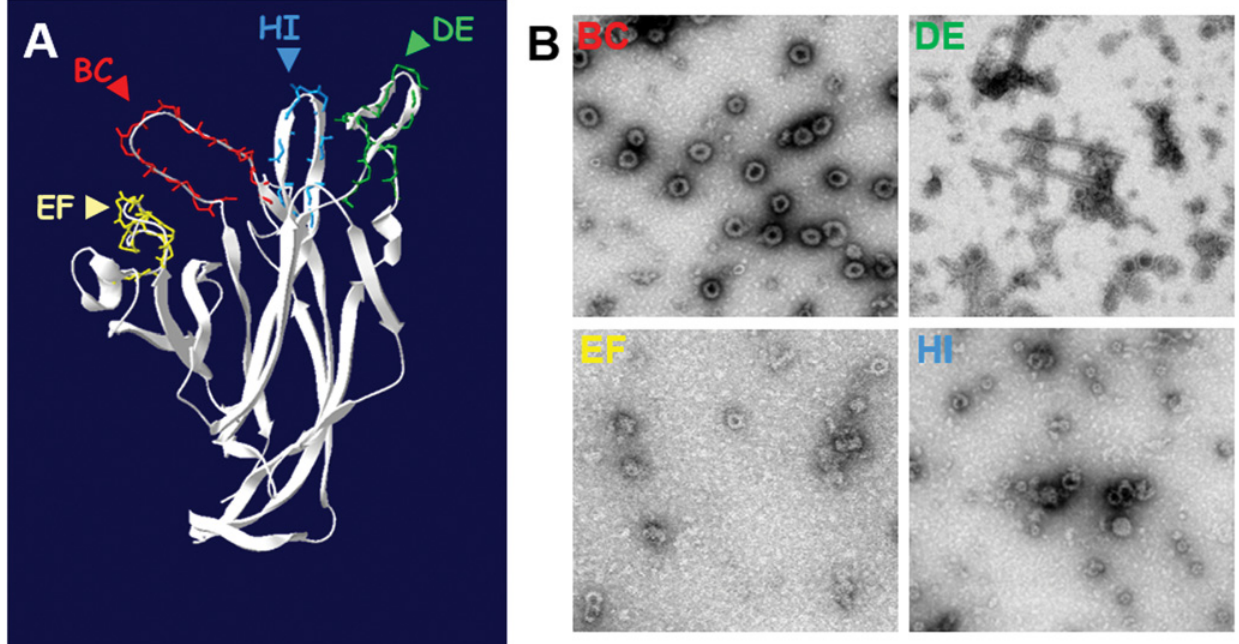
Fig 1. MCPyV VP1 insertional mutants BC, DE, EF and HI. A) MCPyV surface exposed loops model generated using the MKT21 sequence with the VP1 structure information of MCPyV w162 strain (4FMG pdb file) by Swiss-Model. The StreptagII motif (WSHPQFEK) coding sequence was inserted into each predicted surface exposed loop, after S88 of BC, after H150 of DE, after T189 of EF and after T296 of HI to generate four insertional mutants, BC, DE, EF and HI, respectively. B) MCPyV VP1 mutant particles observed by transmission electron microscopy after recombinant baculovirus expression and CsCl gradient